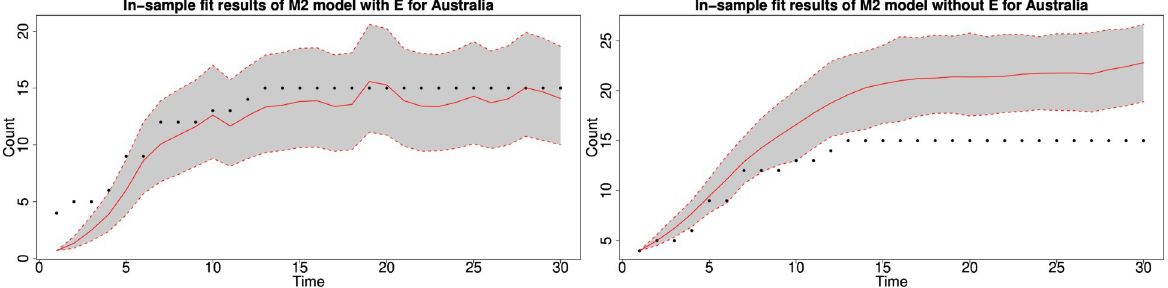
Fig 22. In-sample fit results with the sentiment exposure adjustment for Australia. In-sample fitting plot for Australia by Model 2 for the first month with (left) and without (right) the sentiment exposure adjustment.